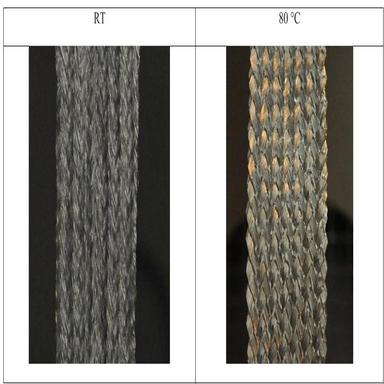
Pictures of test-specimens to the end of test (40 mm displacement) at RT and 80 °C from the pure shear zone of the specimens for the CEP-TW1.